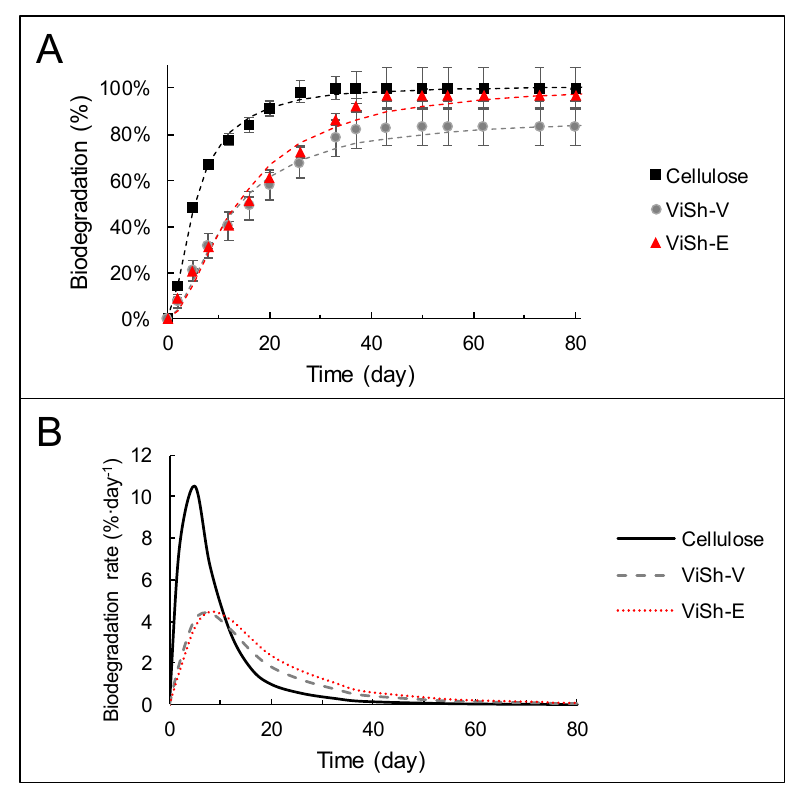
Figure 3. Kinetic of biodegradation ( A ) and biodegradation rate ( B ) of ViSh-fillers in soil.